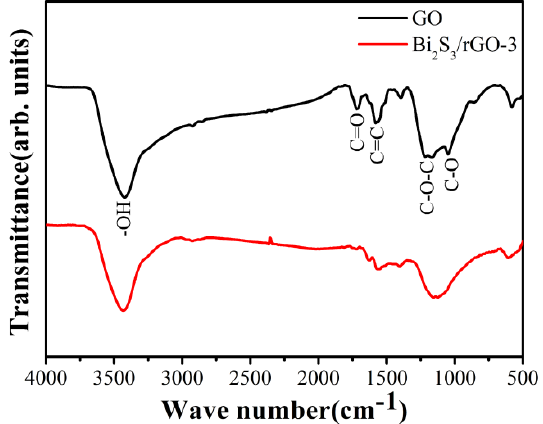
Figure 4. FTIR spectra of GO and Bi 2 S 3 /rGO-3 composite.